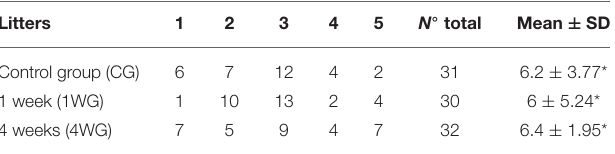
TABLE 1 | Number of puppies in each litter in the 3 study groups. Litters